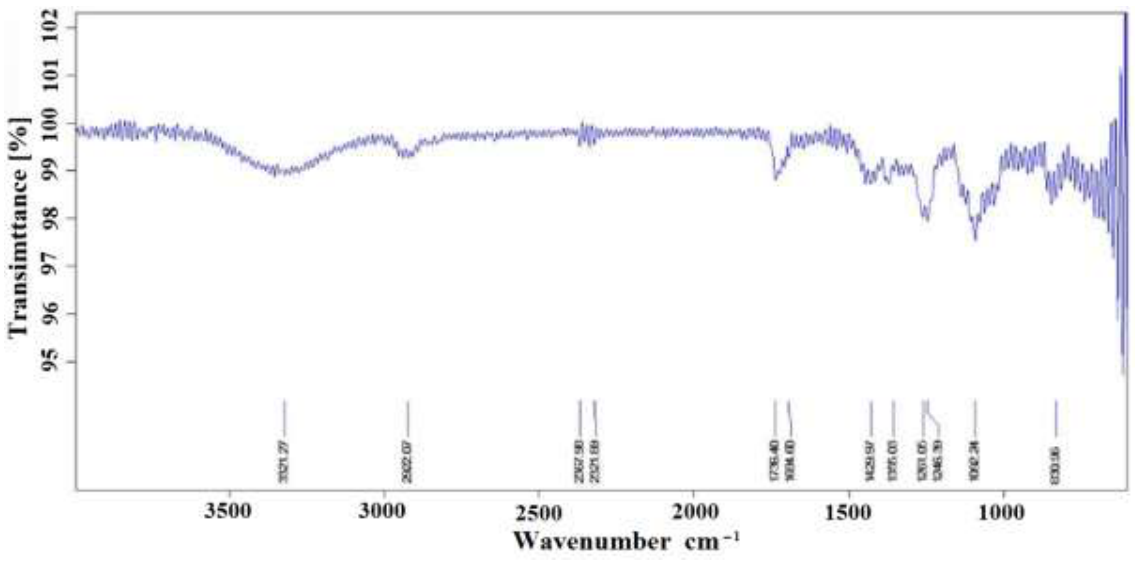
Figure 12: FTIR analysis of the prepared polyvinlyalcohol air